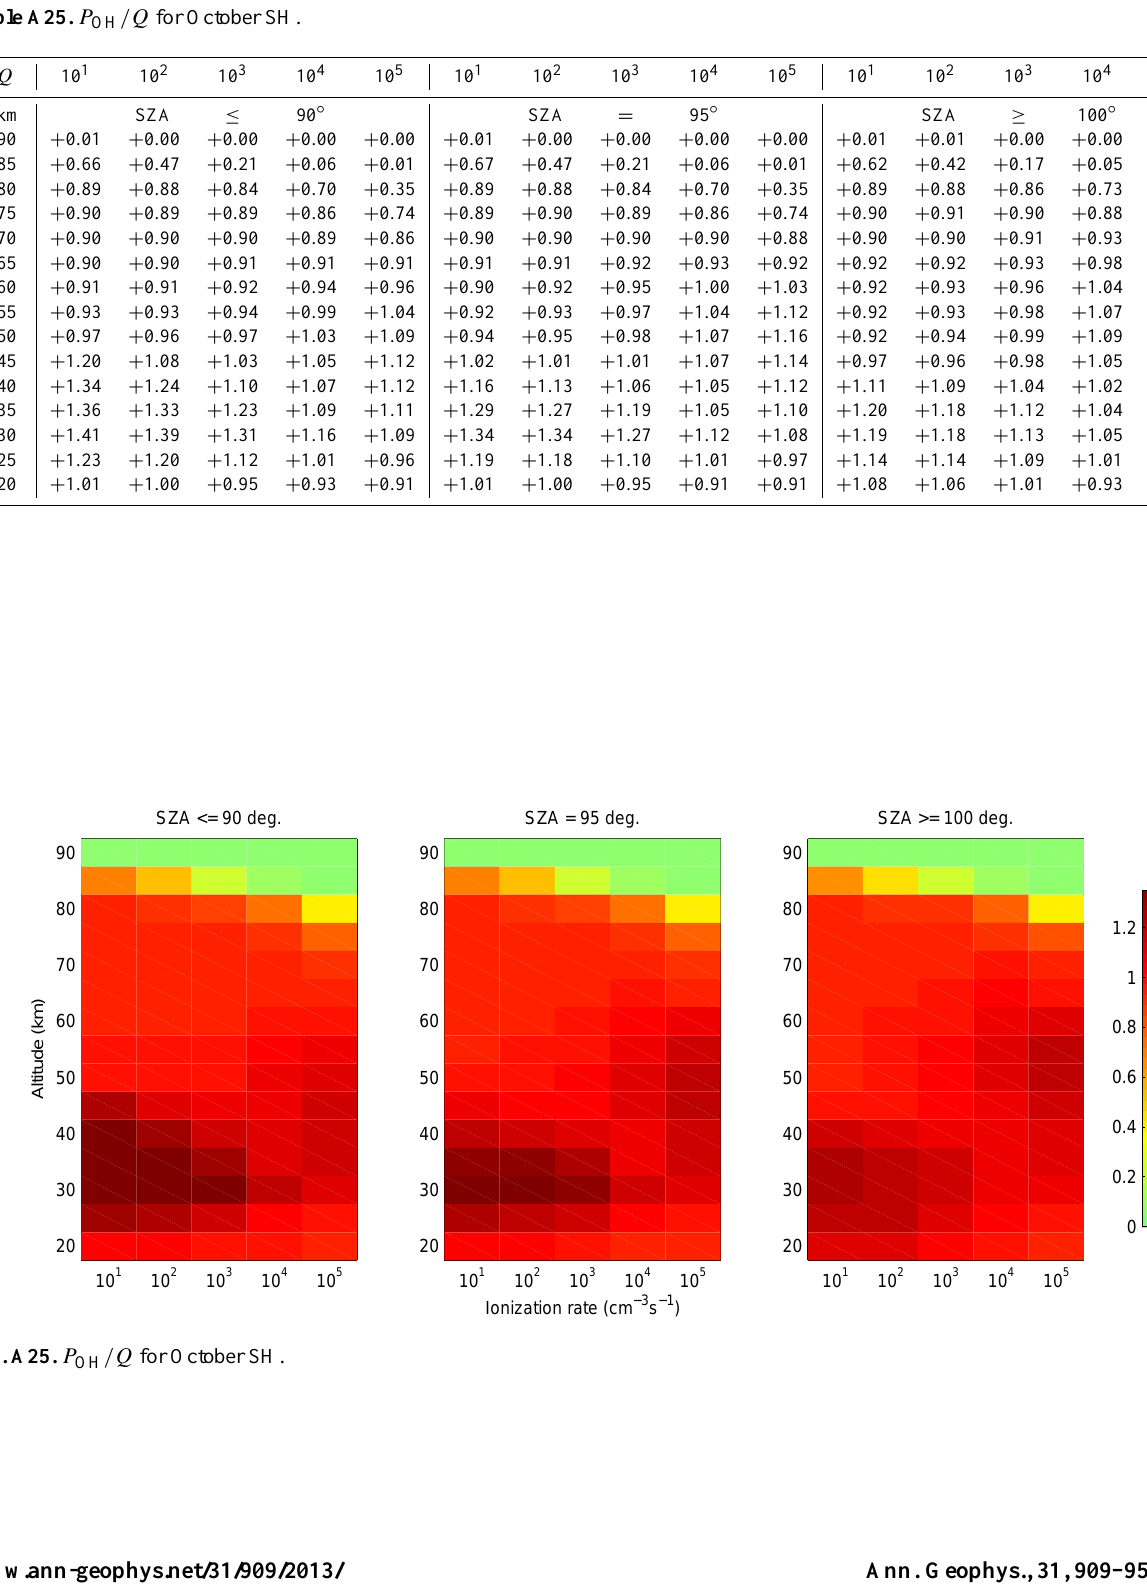
Table A25. P OH /Q for October SH.